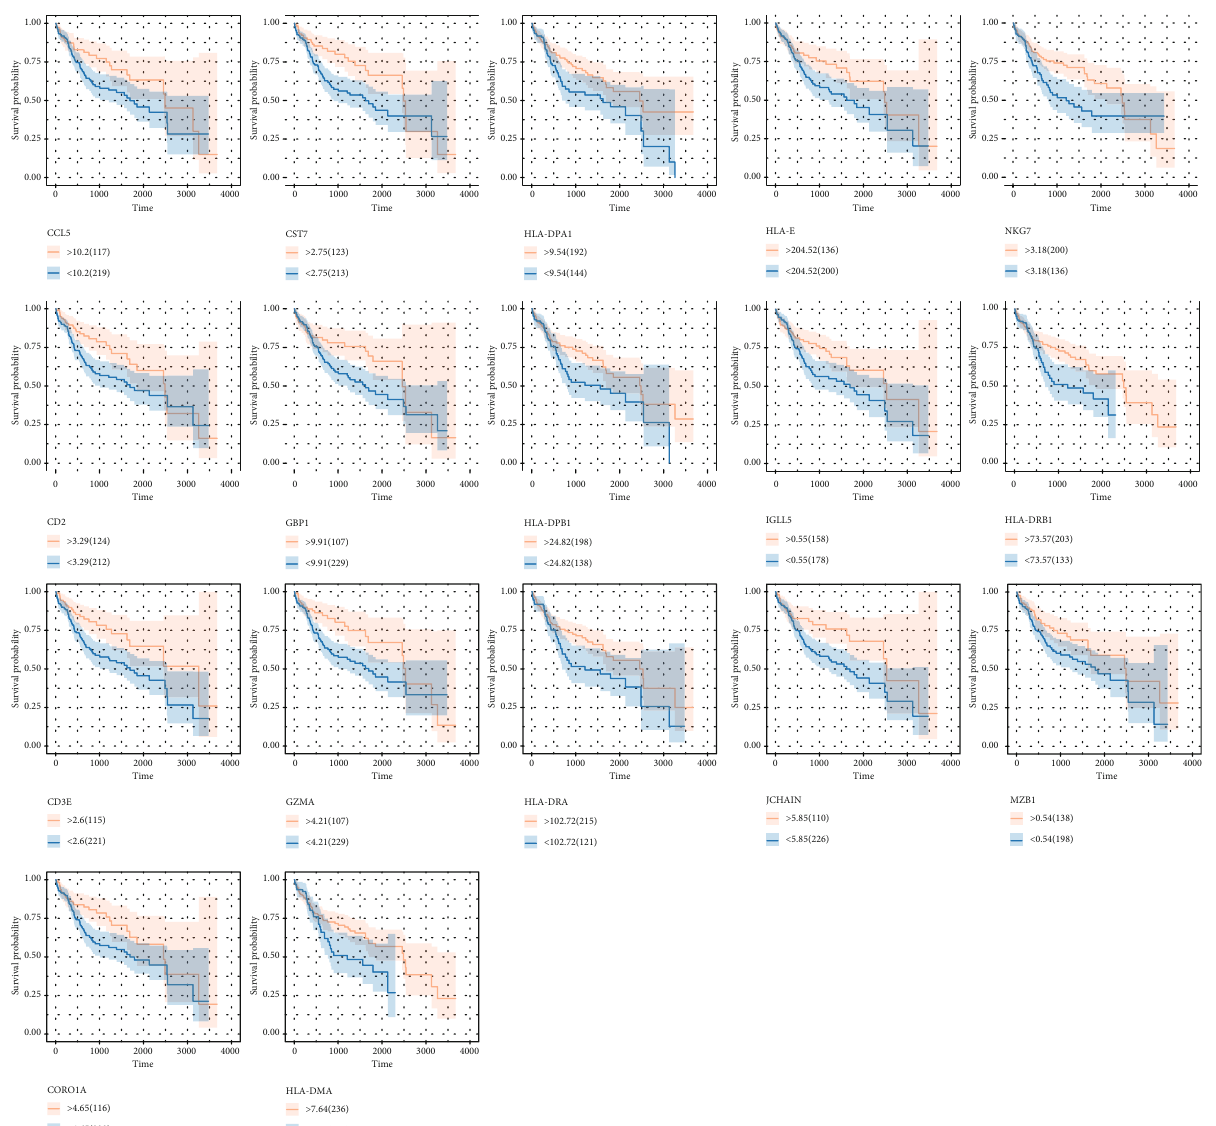
Figure 4: The survival analysis of genes in magenta and grey60 modules. The grey60 module genes acted as prognostic protective (Figure 2(c)). The grey60 module had the strongest correla- tion with CD8+ T lymphocyte proportion in TCGA-LIHC cohort ( cor = 0 : 38 ; p = 4 e − 12 ) (Figure 2(c)). The magenta module correlated with the CD8+ T lymphocyte propor- tion in TCGA-LIHC cohort ( cor = 0 : 31 ; p = 2 e − 08 ) (Figure 2(c)). Based on these fi ndings, we supplemented the heat map of the correlation between the factors in the grey60 and magenta modules (Figures 2(d) – 2(g)). The grey60 module showed a signi fi cant correlation with CD8+ T cells ( cor = 0 : 86 , p = 1 : 5 e − 21 ) and tumor purity ( cor = 0 : 85 , p = 1 : 3 e − 20 ). The magenta module showed a signi fi cant correlation with CD8+ T cells ( cor = 0 : 65 , p = 4 : 3 e − 20 ) and tumor purity ( cor = 0 : 96 , p = 4 : 9 e − 87 ). 3.3. CD8+ T Lymphocyte Coexpression Module Functional Analysis. We determined the top 20 CD8+ T lymphocyte